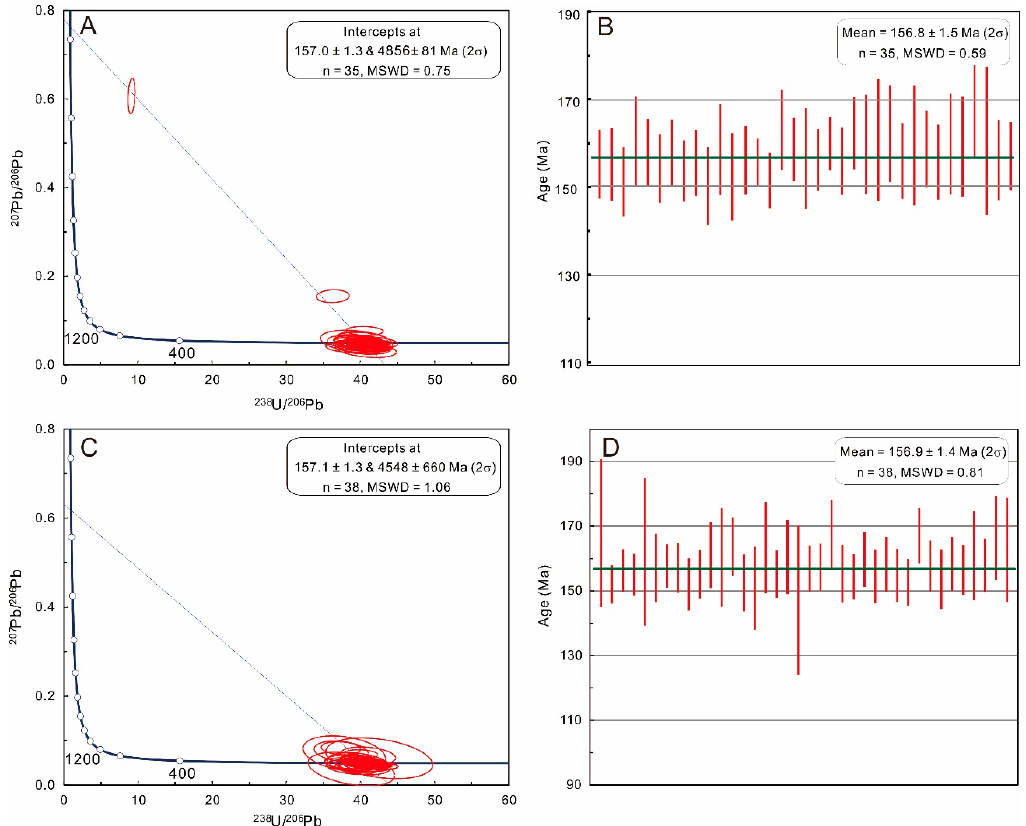
Figure 9. Tera-Wasserburg U–Pb concordia plots and weighted mean 206 Pb/ 238 U age diagrams for cassiterite from the Maoping W–Sn deposit. ( A,B ) Sample Mp–5–11 from quartz vein ore. ( C,D ) Sample Mp-75-17 from greisen ore.